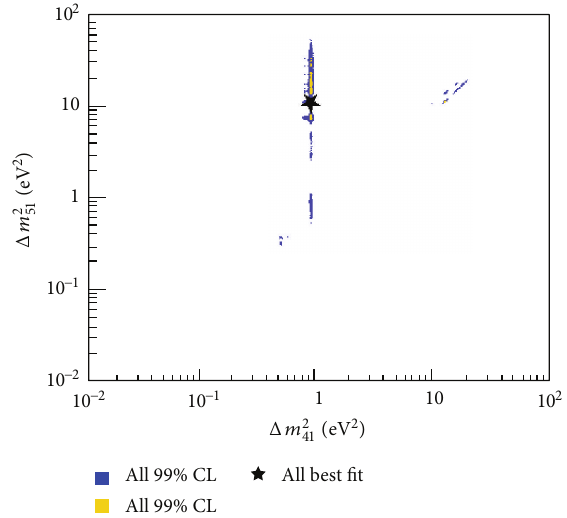
Figure 7: The Δ𝑚 2 51 versus Δ𝑚 2 41 allowed space from fits to all data in a ( 3 + 2 )